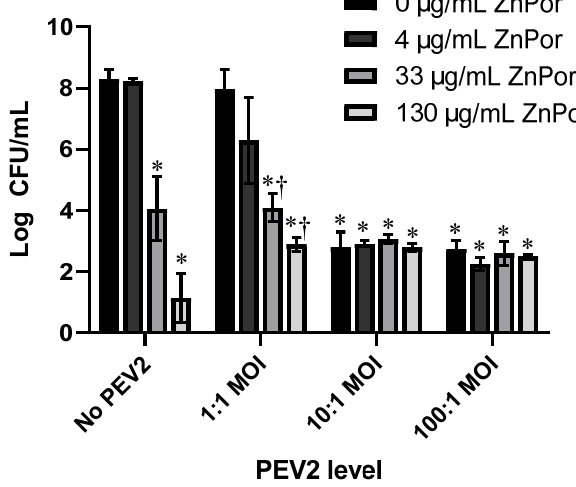
Figure 3. Assessment of ZnPor/PEV2 combinatorial effects against PsA PAO1 cells within 96-well plates. H441 cells were infected with PsA cells at an MOI of 10,000:1 (H441 to PAO1 cells) and dosed with either ZnPor or PEV2 alone, as well as ZnPor in combination with the PEV2 bacteriophage. PAO1 viability was measured after 24 h using the viable plate count assay (CFU per mL). * Indicates significance from PsA control; and † indicates statistical significance between PEV2 alone and ZnPor + PEV2 treatment at the same MOI ( p < 0.05, n = 3). CFU/mL, colony-forming units/mL; MOI, multiplicity of infection.